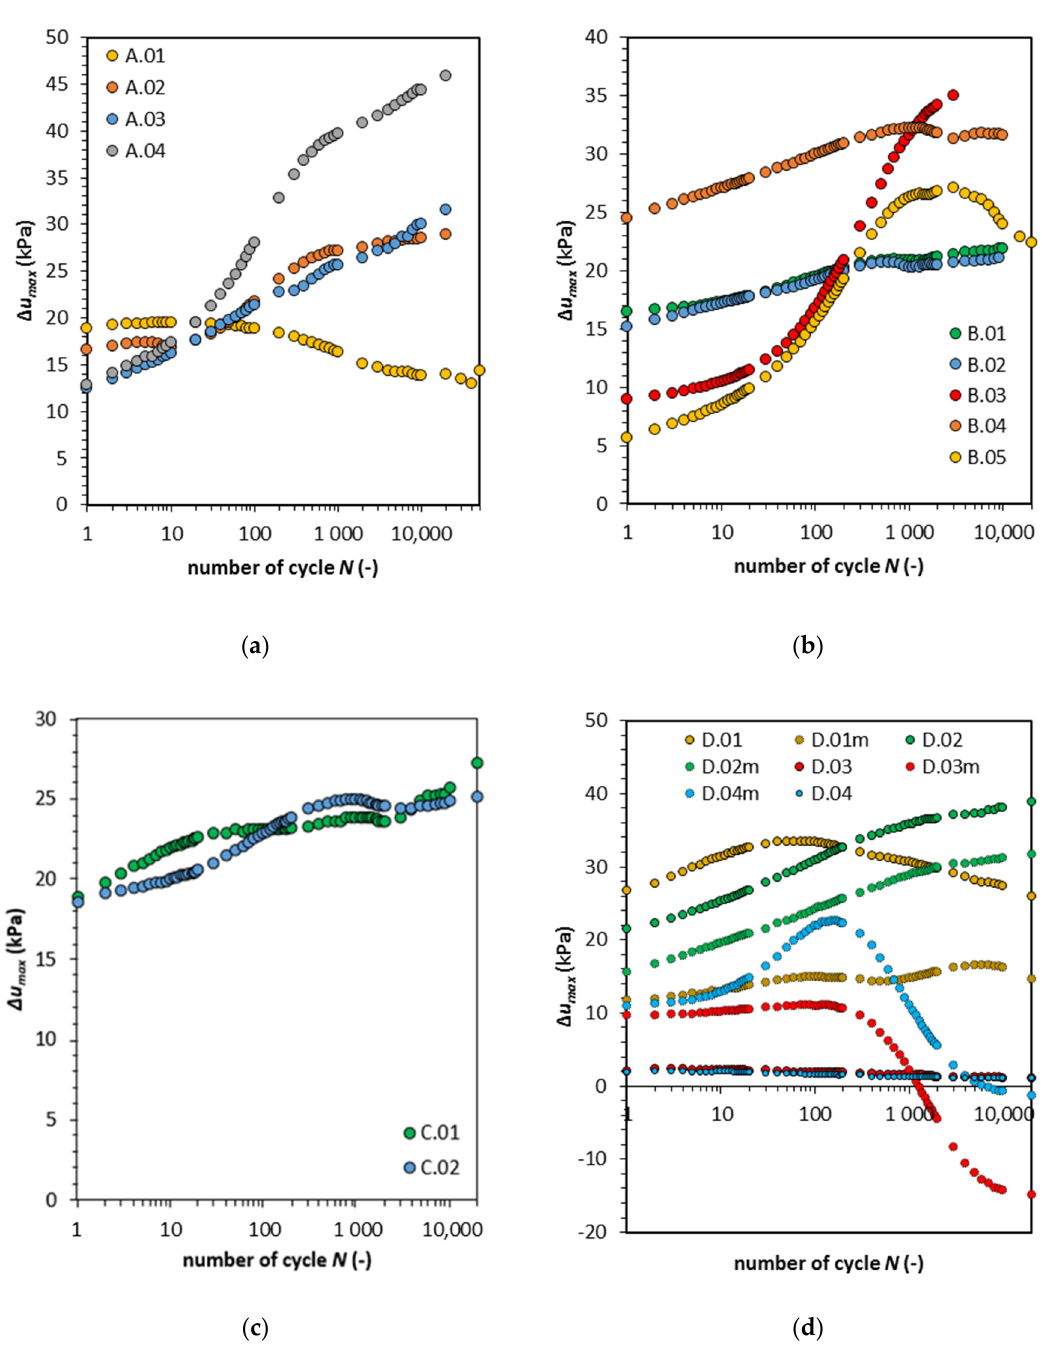
Figure 5. Maximum excess pore water pressure versus the number of cycles. ( a ) Type 1; ( b ) Type 2; ( c ) Type 3; ( d ) Type 4.